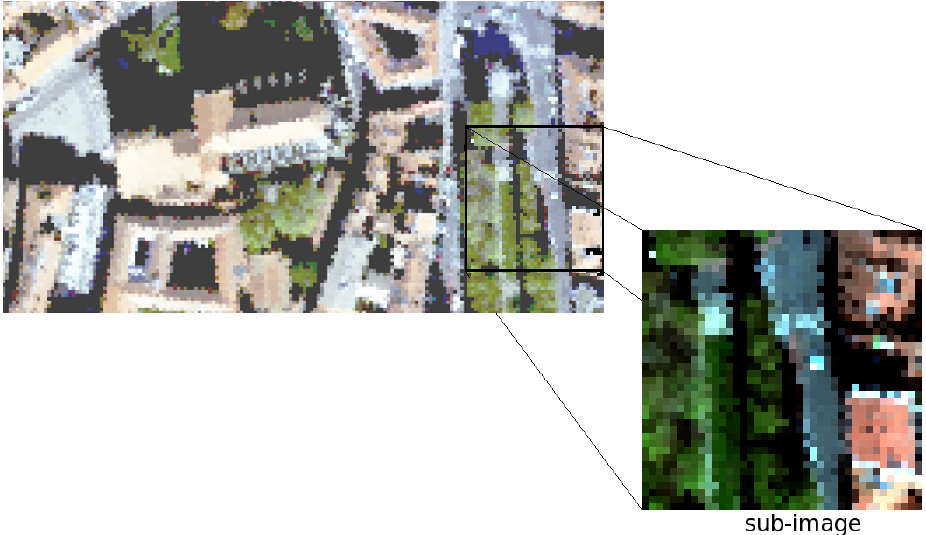
Figure 10. Extracted